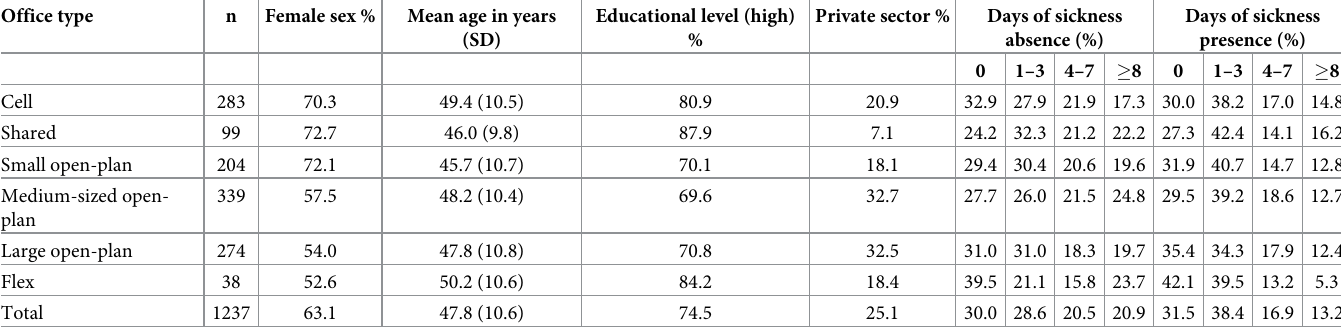
Table 3. Description of the respondents in the self-reported sickness absence and sickness presence sample (n = 1237). Office